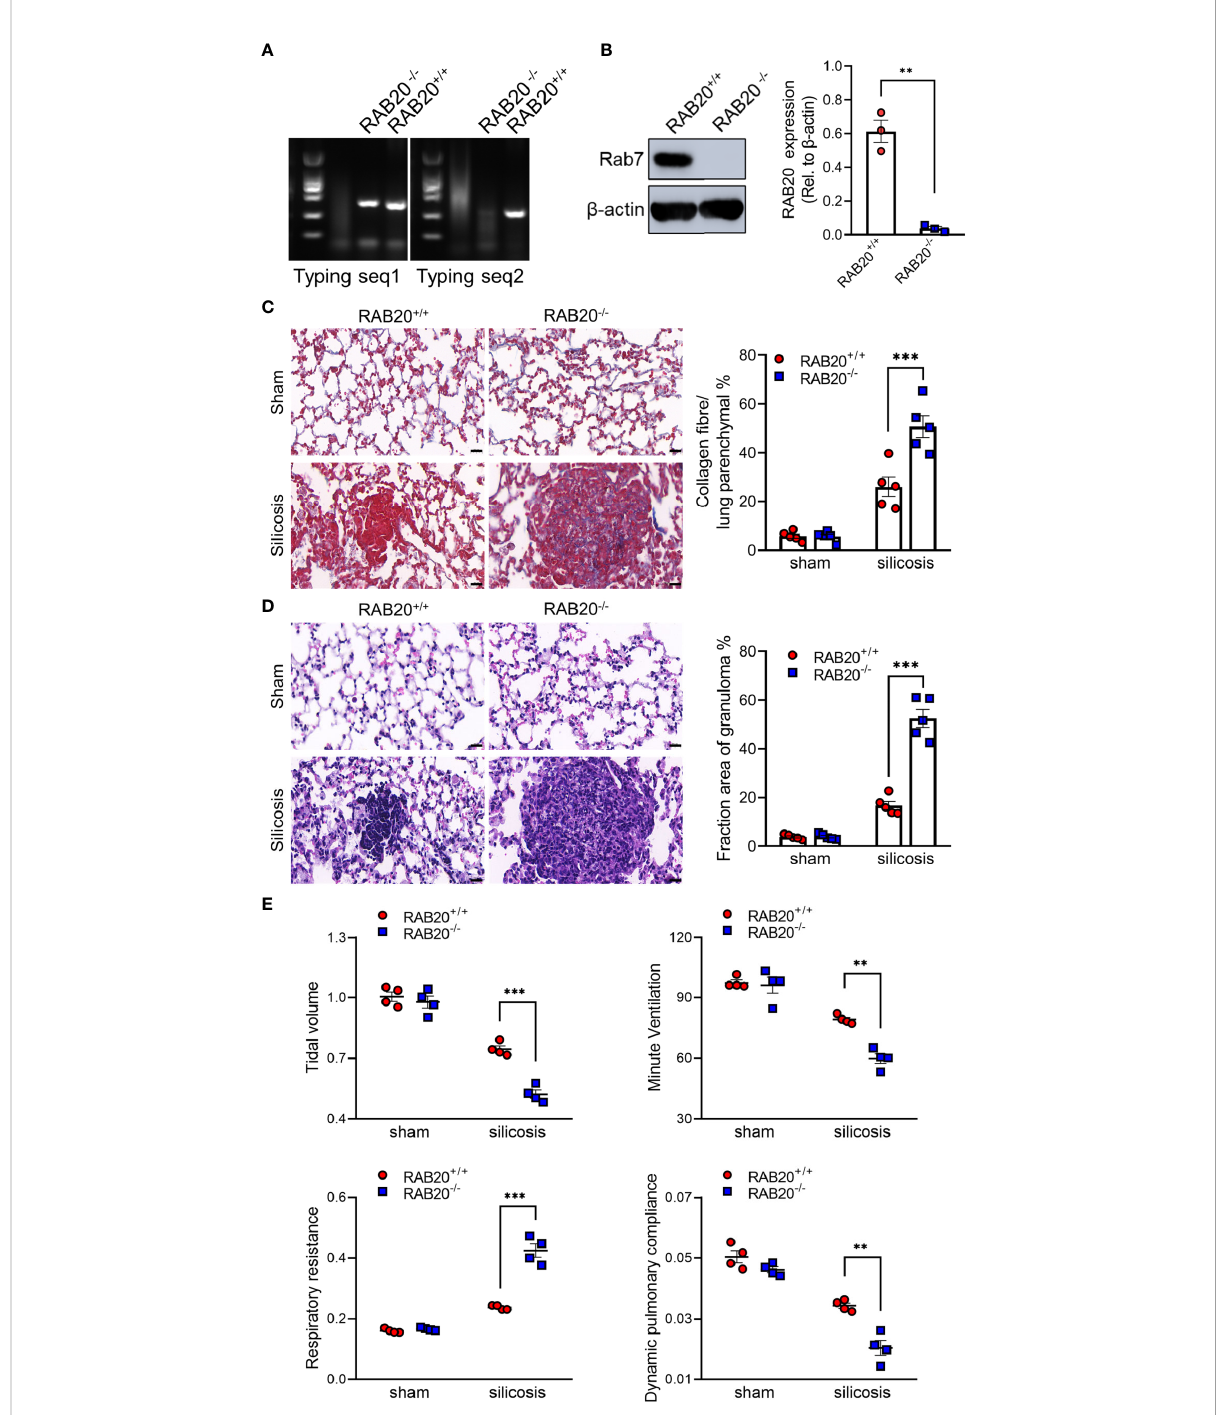
FIGURE 2 RAB20 de fi ciency promotes silica crystal-induced pulmonary interstitial fi brosis and respiratory dysfunction. (A) Typing lane of RAB20 in wild type and RAB20 knockout mouse. (B) Immunoblotting for RAB20 and b -actin in the lung tissues of wild type and RAB20 knockout mouse. (C) H&E staining of lung tissues in wild type or RAB20 knockout mice with or without silica crystals. Morphometry analysis quantifying granuloma area in the lungs. (D) Masson staining of lung tissues in wild type or RAB20 knockout mice inhaled with or without silica crystals. Morphometry analysis quantifying collagen fi ber area in the lungs. (E) Wild type or RAB20 knockout mice were subjected to lung function assessment. Resistance index (RI), dynamic compliance (Cdyn), tidal volume (TV), and minute volume (MV) were measured. **p < 0.01; ***p < 0.001 (unpaired/two-tailed t test, one-way and two-way ANOVA test). Data are shown as mean ± SEM from three independent experiments. Scale bar represents 50 m